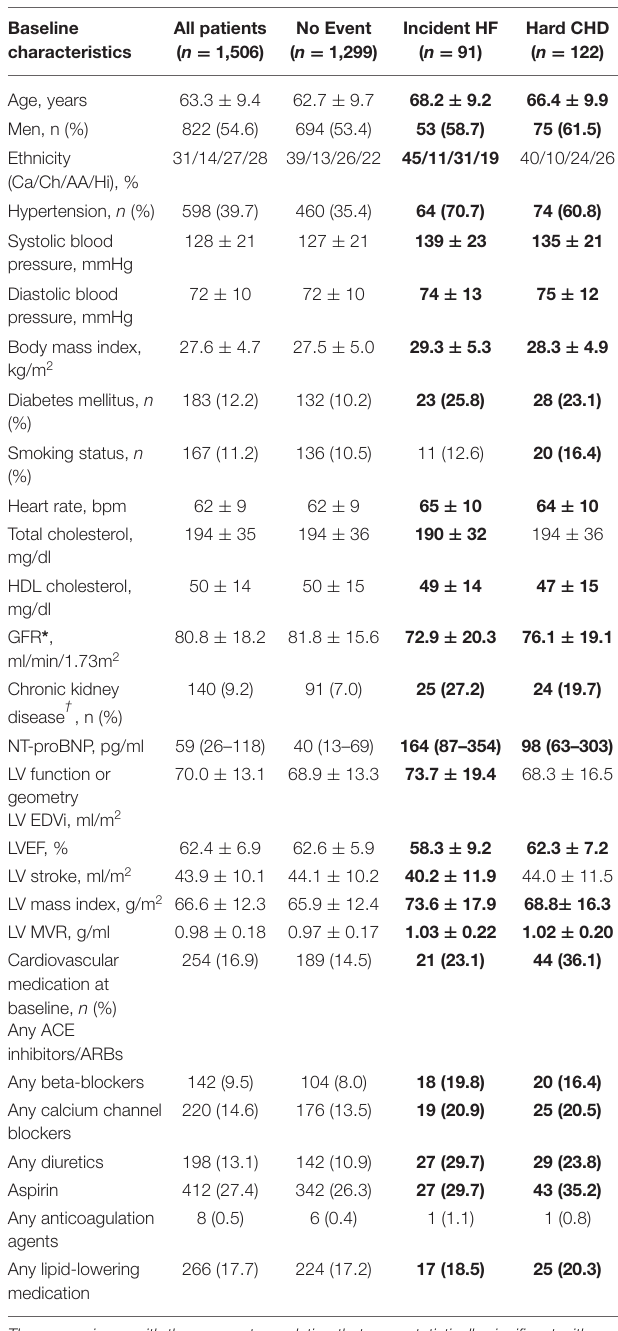
TABLE 1 | Population characteristics of participants at baseline before occurrence of events by incident event categories. Baseline